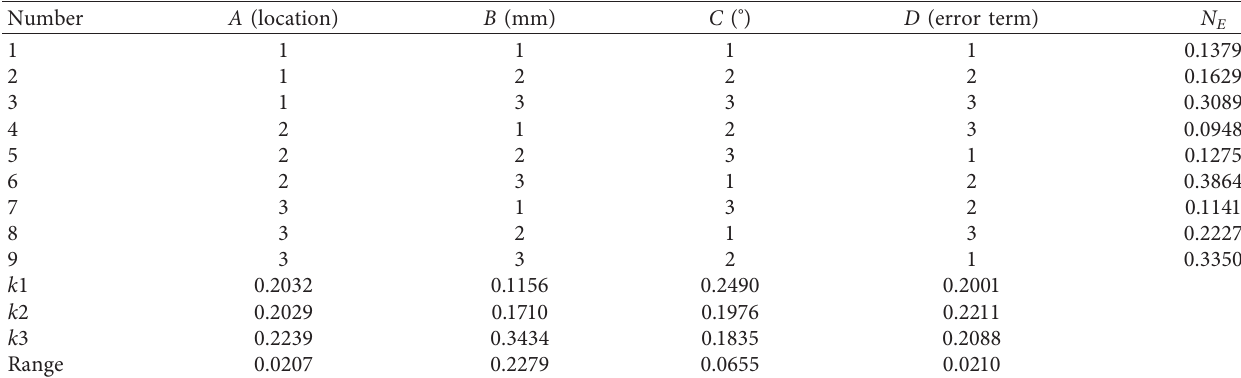
Table 7: Orthogonal test sets and visual analysis.